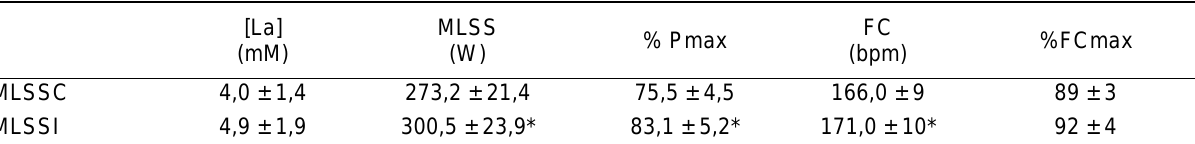
Tabela 2. Valores médios ± DP da concentração de lactato sanguíneo ([La]), intensidade absoluta (MLSS) e